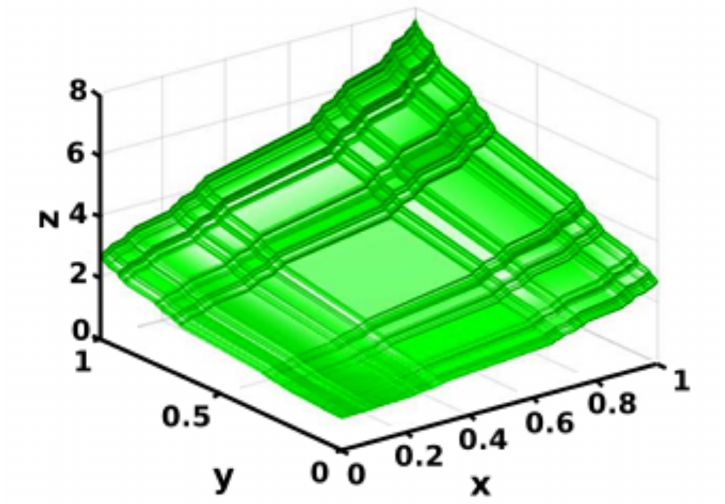
Figure 3. The u component (Equation (26)) is the fluid velocity in the fractal space for the function ( x ) + γ S α ( y )) for which α = 0.63, β = 1, γ = 1, A = 1, B = 1, c = 1. f = exp ( β S α F F